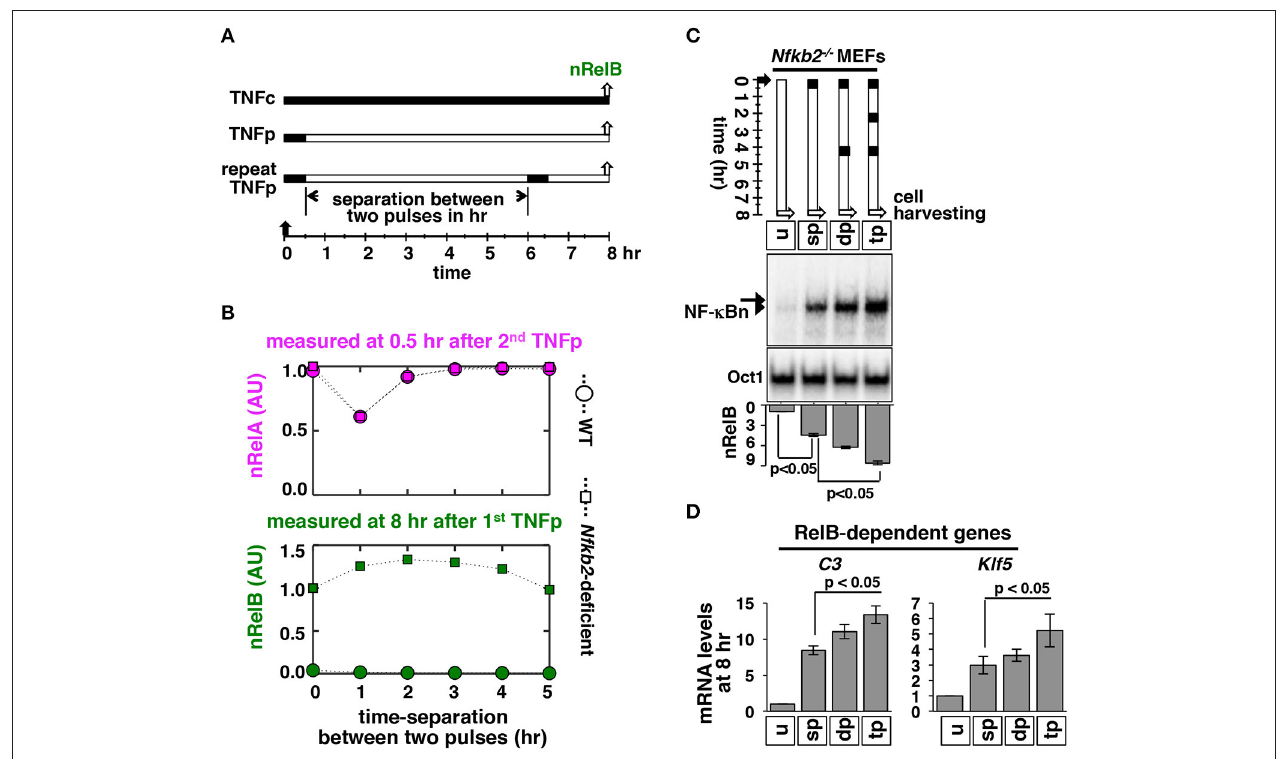
FIGURE 7 | Repeated TNF pulses of Nfkb2 − / - cells strengthen late RelB:p50 signaling. (A) Schema describing repeated TNFp regime: the short-lived IKK2 input associated with the TNFp regime was fed into the model successively with varied separation time between two TNF pulses and corresponding NF- κ Bn was simulated. (B) Computational studies revealing the early nRelA activity induced 0.5h after the second TNFp (top) and the late nRelB activity induced 8h after the first TNFp (bottom) as a function of the separation time between two successive pulses in WT and Nfkb2 -deficient systems. The early and late activities were normalized to those induced in response to a single pulse in the Nfkb2 -deficient system. (C) Nfkb2 − / − MEFs were treated with either a single TNFp (single pulse, sp) or two successive TNFp separated by 4h (double pulse, dp) or three pulses at 2h intervals (triple pulse, tp). Cells were harvested 8h after the first pulse and analyzed for NF- κ Bn by EMSA. u denotes untreated. Bottom: quantitative analysis of the nRelB activities; data represent three experimental replicates. (D) Nfkb2 − / − MEFs were subjected to the indicated treatments; cells were harvested 8h after the first pulse and expressions of the indicated genes were measured by qRT-PCR. Bargraphs represent three biological replicates. Quantified data presented in this figure are means ± SEM of three biological